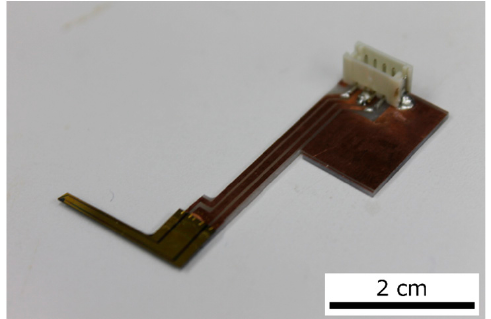
Figure 3. The piezoresistive cantilever and the printed circuit board. The connectors are soldered to the board, and electrical signals are transmitted through these connectors to the bridge circuit.